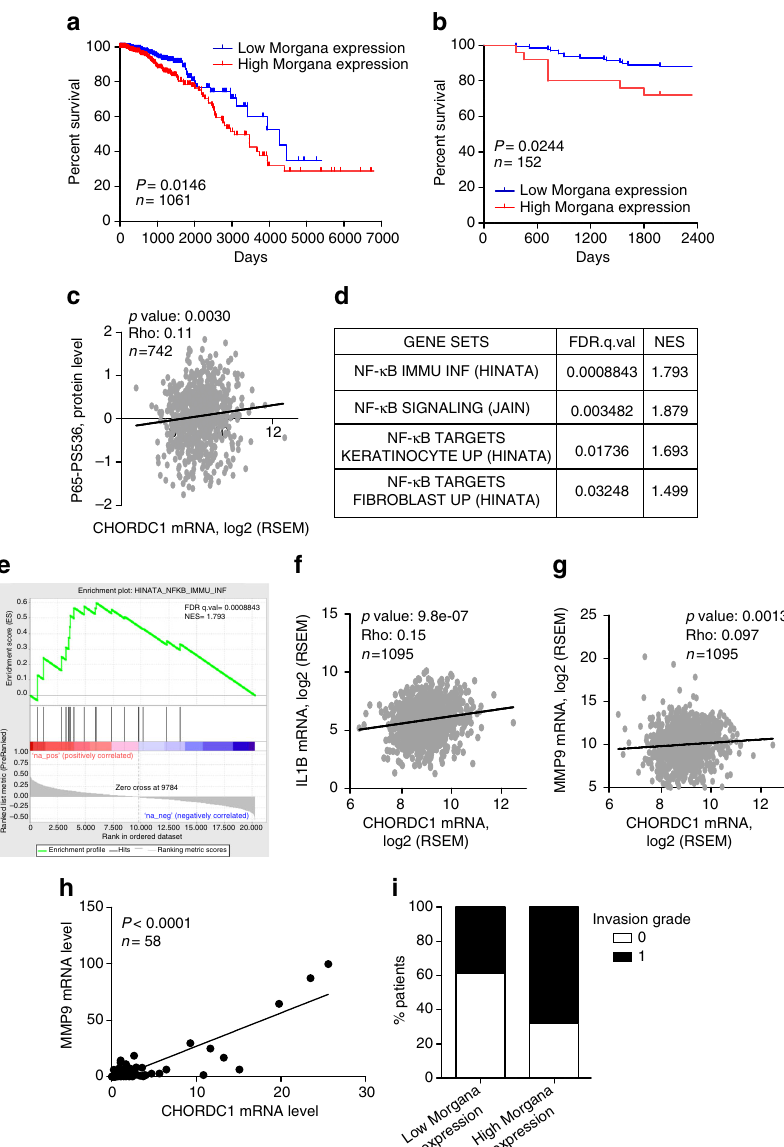
Fig. 5 Morgana is co-expressed with NF- κ B target genes in human breast cancers. a Morgana expression signi fi cantly correlated with poor survival in TCGA dataset ( P = 0.0146, Mantel-Cox test). b Morgana expression signi fi cantly correlated with poor survival in San Giovanni Battista Hospital (SGBH) cohort of 152 patients ( P = 0.0244, Mantel-Cox test). c Spearman correlation between CHORDC1 (Morgana coding gene) mRNA levels and the phosphorylation status of NF- κ B p65 in Ser536 in 742 samples of TCGA dataset. d Table showing signature positively correlated with CHORDC1 mRNA levels generated by GSEA analysis of ranked NF- κ B gene expression data in TCGA dataset. e Gene set enrichment analysis plot of the most CHORDC1- positively correlated NF- κ B dataset. f , g Spearman correlation in mRNA levels between CHORDC1 and IL1B f and MMP9 g in TCGA data set ( n = 1095). h Spearman correlation in mRNA levels between CHORDC1 and MMP9 in 58 patients from SGBH cohort. i Correlation between Morgana expression levels and vascular invasion grade indicated as 0 or 1 in 152 human breast cancer samples of SGBH